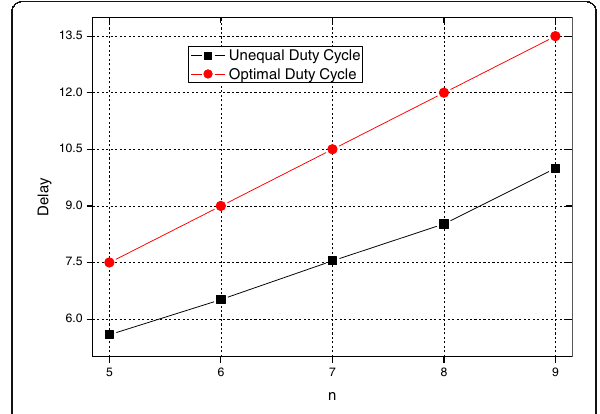
Fig. 16 The delay of UDCNP and ODCNP (MQAM)